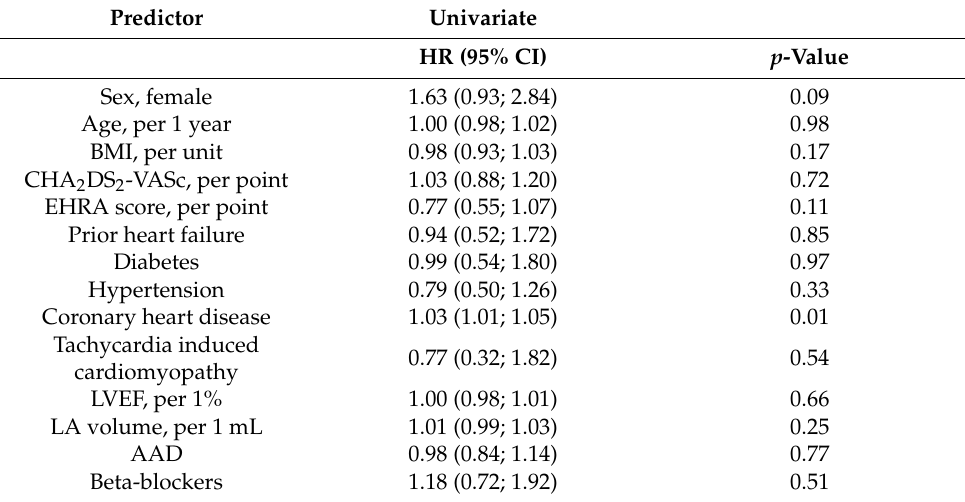
AAD = anti-arrhythmic drug; BMI = body mass index; LA = left atrium; LVEF = left ventricular ejection fraction. HR: Hazard ratio; CI: Confidence interval; CHA 2 DS 2 -VASc: Congestive heart failure, Hypertension, Age, Diabetes, Stroke, Vascular disease, Sex